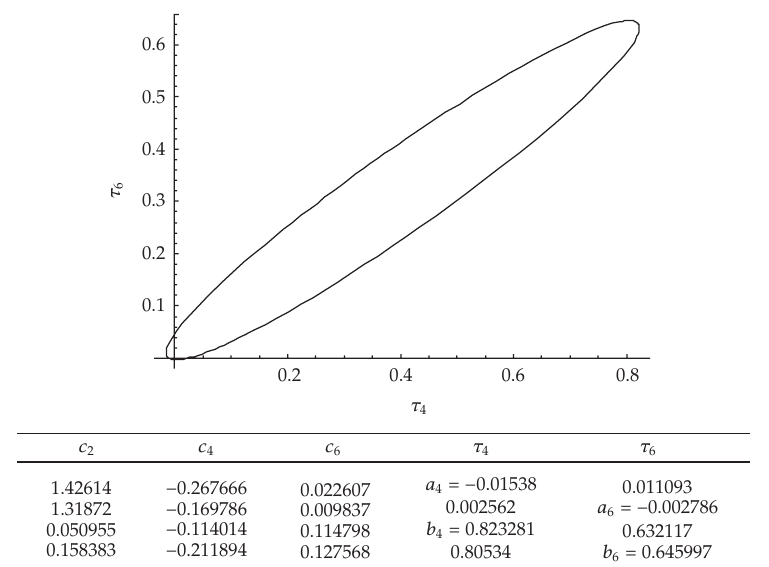
Figure 5: Boundary region and values of L- kurtosis τ 4 and τ 6 for symmetric fifth-order standard normal- based power method pdfs. Valid pdfs exist inside the elliptical graph. The point at the origin represents the regular uniform distribution (cid:2) τ 4 (cid:7) τ 6 (cid:7) 0 (cid:3) . Note that a 4 and a 6 are lower limits and b 4 and b 6 are upper